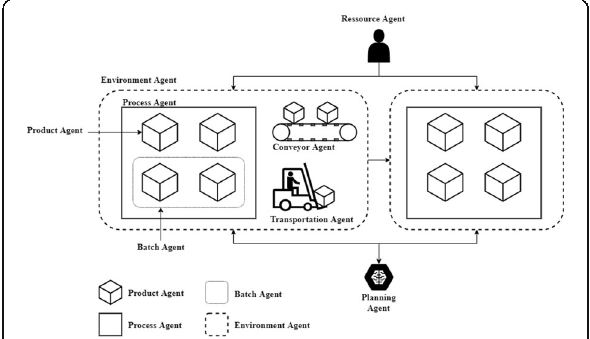
Fig. 10 (Abstract P9). Industrial Production Process Digital Twin Overview.